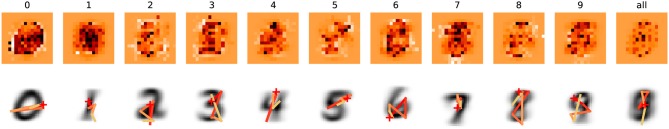
Action maps and pre-processed trajectories. Upper row (except rightmost map) color-coded pre-processed guess-consistent action maps for z^∈{0,..,9}, and u∈{0, .., 15}2, using the baseline generative model, from low (whitish) to high (brownish) log posteriors. Upper row, rightmost map: Class-independent expected IGLB map. Lower row: Corresponding pre-processed visual scan-path (the red “+” provides the initial gaze orientation). Only the 5 first saccades are shown, with average class prototype in the background. The rightmost background image is the average over all classes.